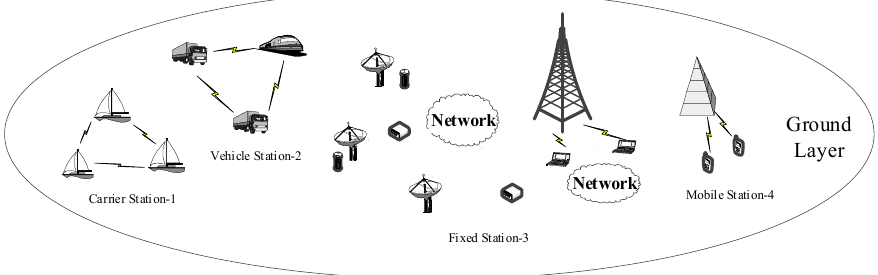
Figure 4. Composition structure of Ground layer terminals.